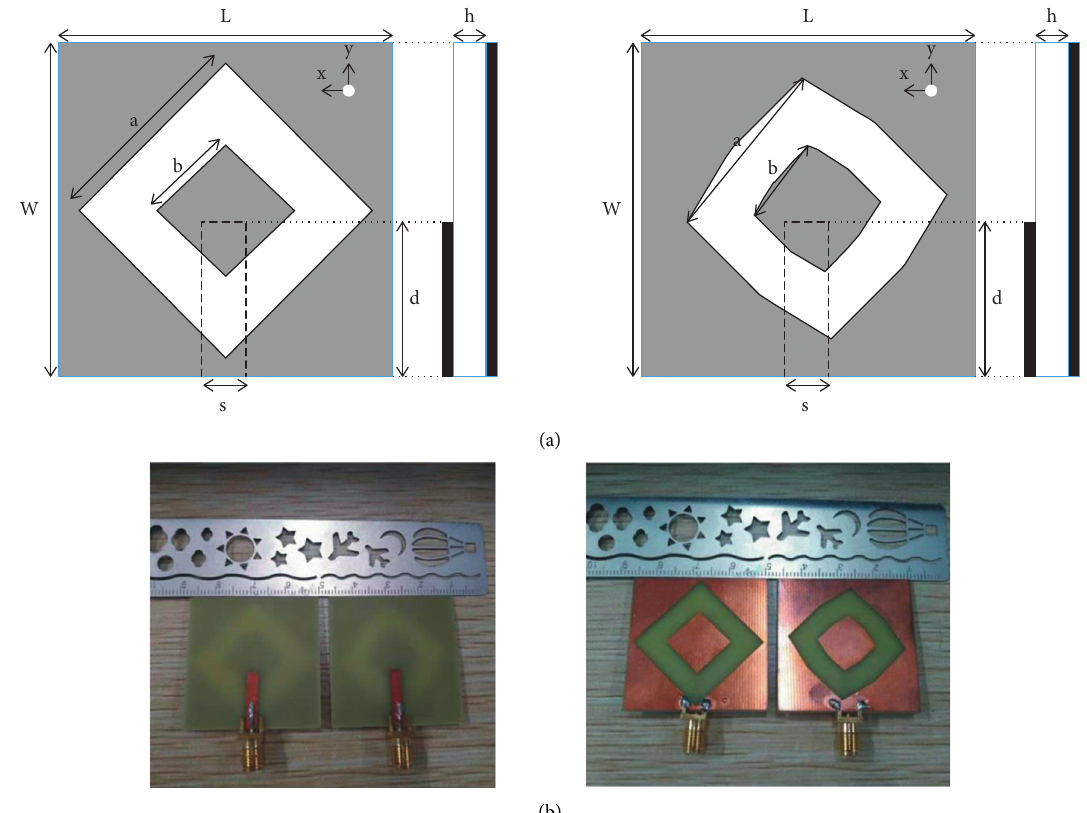
Figure 6: (a) Reference antenna structure and (b) proposed antenna